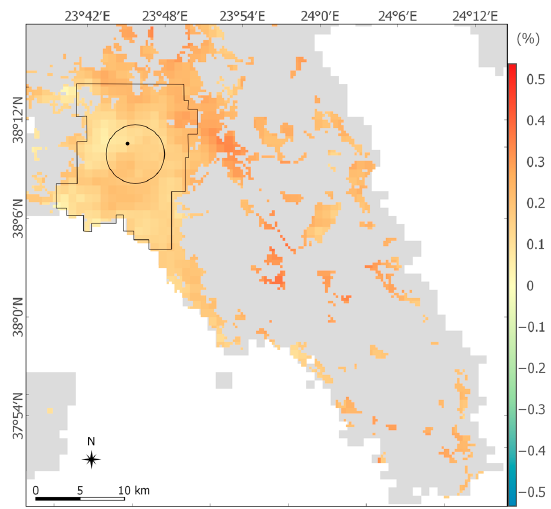
Figure 4. Nighttime LST trends of the urban pixels of Athens. The solid line indicates the boundary of the urban district, the circle indicates the urban core of the city and the point indicates the pixel selected for time series analysis. (gray: outside study area and non-urban pixels, white: sea). The daytime LST trend patterns of the other cities follow the pattern of Athens, as a clear connection between urban density and LST trend values is apparent (Figure 5a,c,e,g). The urban cores of Marseille, Barcelona and Rome exhibit the highest positive LST trend values reaching +0.3%, although the average urban LST trends have slightly negative values, due to the many urban pixels in the outskirts of the city characterized by different built-up densities than the urban core of the city. In Figure 6 the time series of one pixel inside the urban core of each city are presented. The selected pixels are located in the indicated urban core areas (see Figures 3 and 5) and correspond to high positive daytime trends of the urban core.